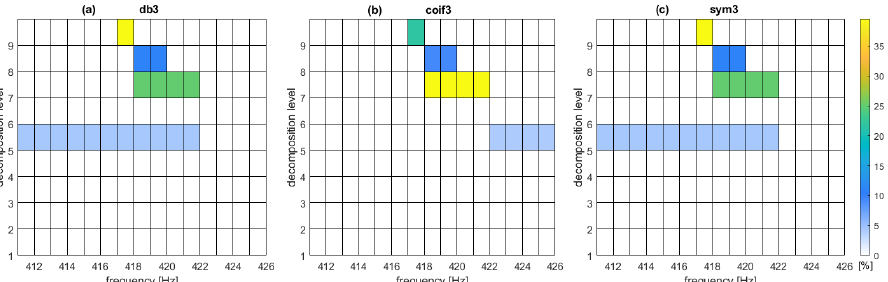
Figure 3. DW function values (yellow: maximum; blue: higher; green: lower and light blue: minimum values) expressed in [%]: ( a ) db3- Daubechies wavelet; ( b ) sym3- Symlet; ( c ) coif3 – Coiflet.